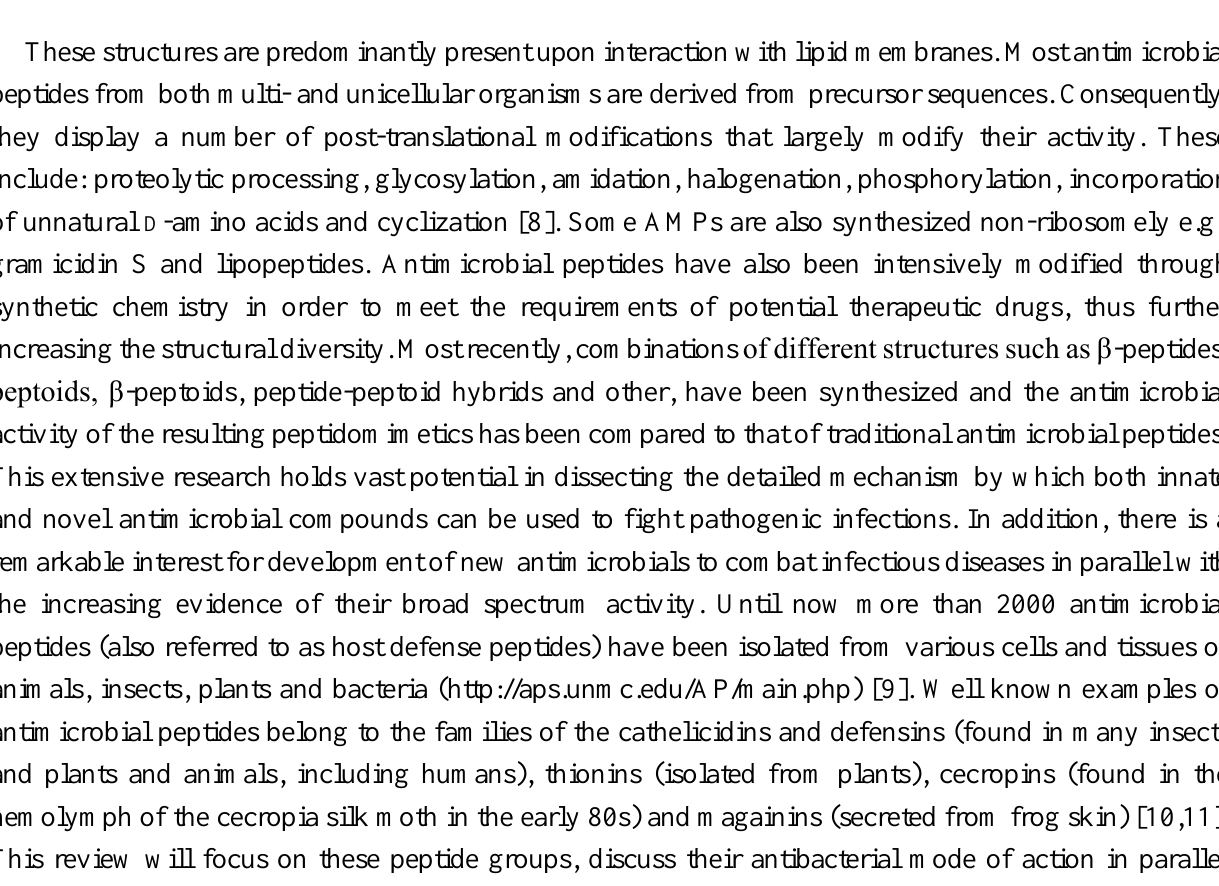
Figure 1. Four structural classes of antimicrobial peptides. ( A ) α-helical structure of human cathelicidin LL-37 (PDB code 2K6O [4]); ( B ) β-sheeted polyphemusin (PDB code 1RKK [5]); ( C ) extended indolicidin (PDB code 1G89 [6]); ( D ) and mixed structures like human β- defensin-2 (PDB code 1FQQ